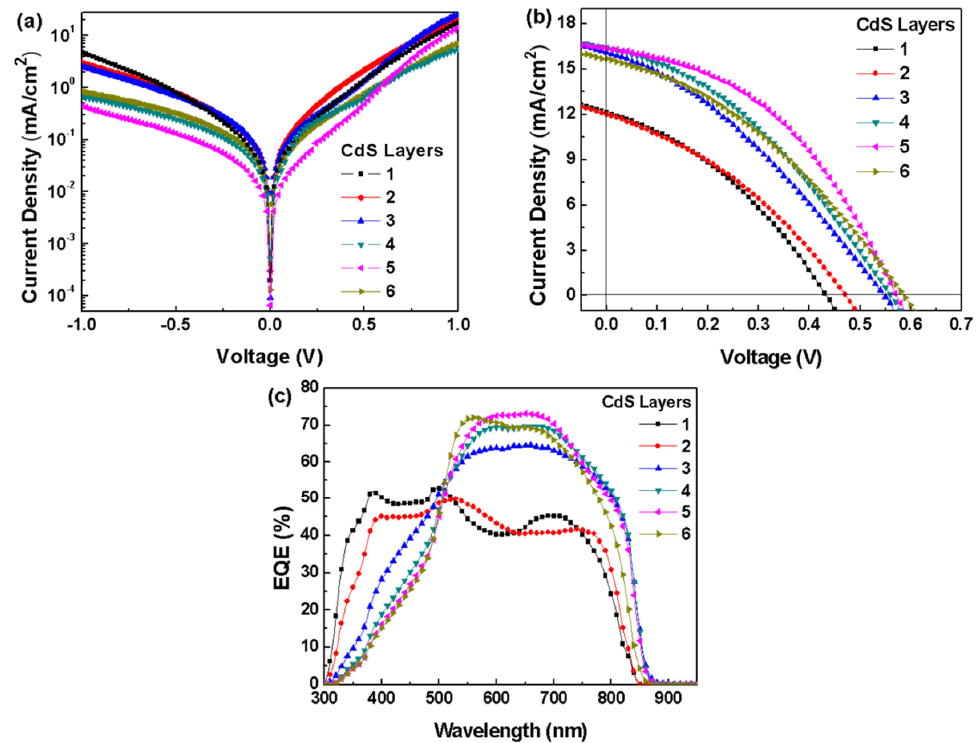
Figure 4. J – V curves of CdTe/CdS NC solar cells with different CdS thickness ( a ) under dark and ( b ) under light; ( c ) EQE spectra of CdTe/CdS NC solar cells.